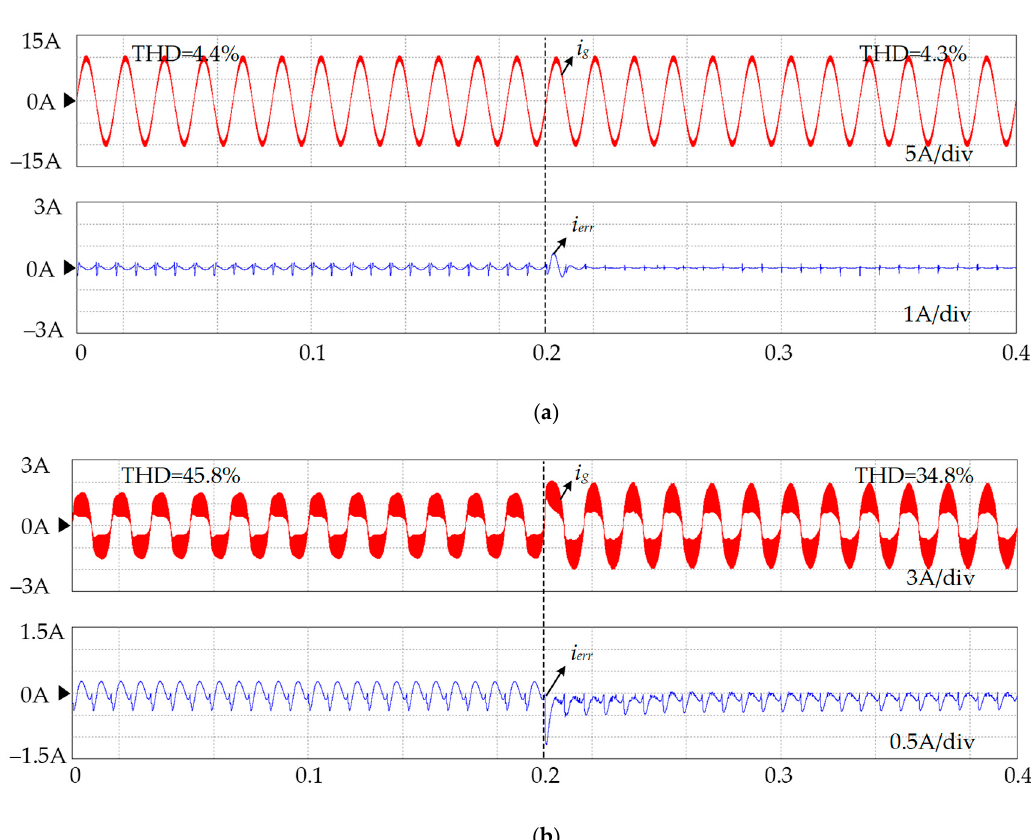
Figure 12. Simulation results applying repetitive controller at 0.2 s in boost mode: ( a ) Input current and current error at load = 800 W; ( b ) Input current and current error at load = 100 W.